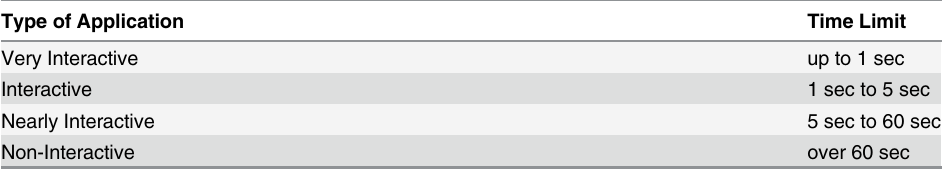
Table 1. Type of application and time